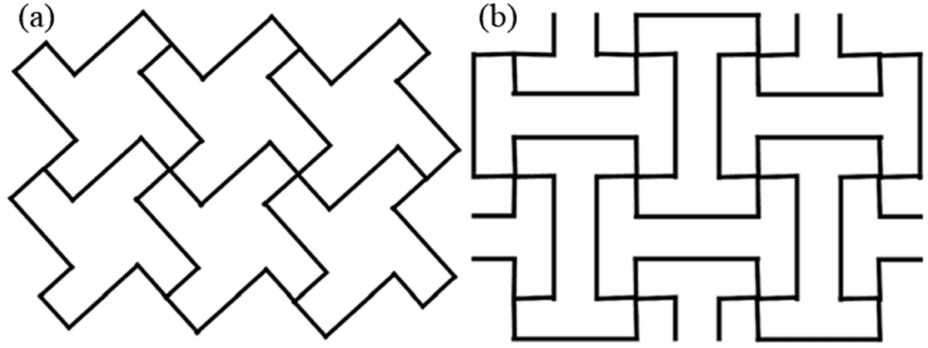
Figure 10. Auxetic foam geometries. ( a ) lozenge grid [24,63], and ( b ) square grid